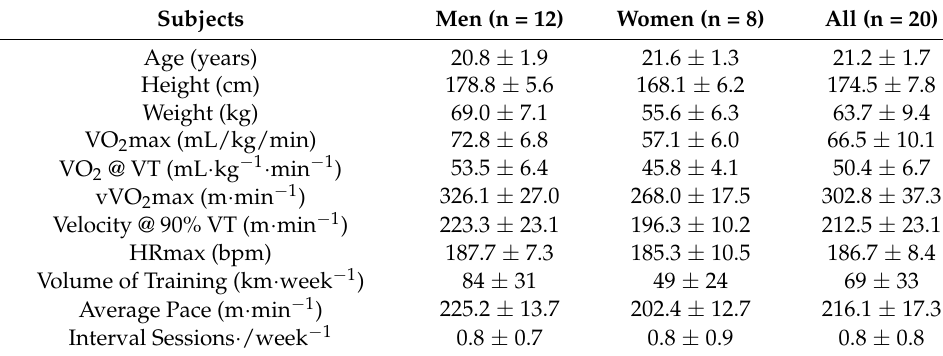
Table 1. Characteristics (mean + sd) of the